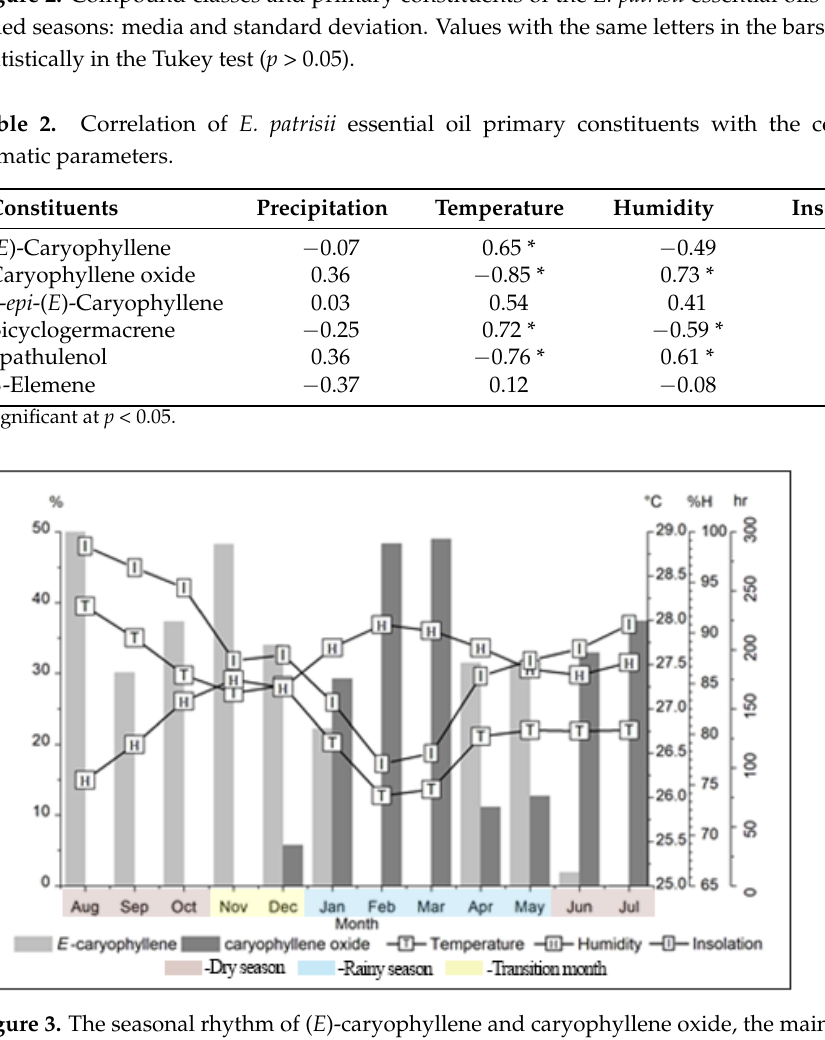
Figure 3. The seasonal rhythm of ( E )-caryophyllene and caryophyllene oxide, the main constituents of E. patrisii essential